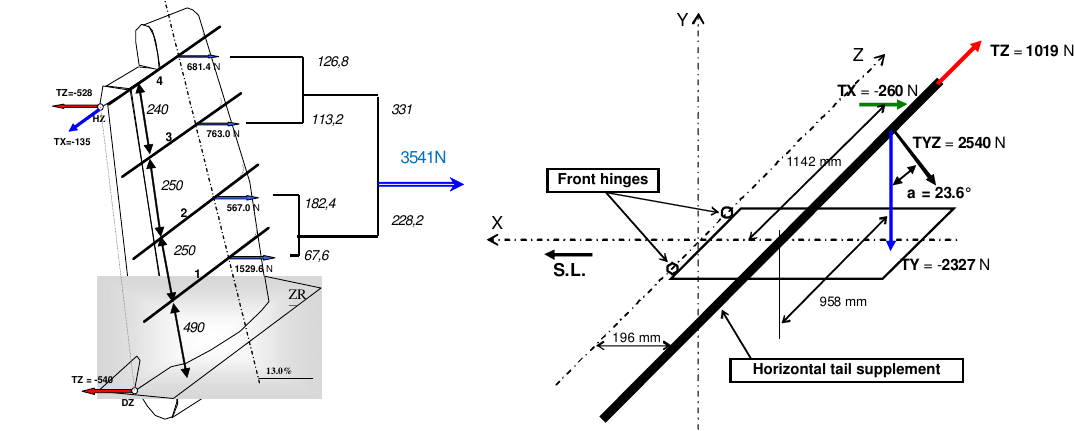
Fig 1. Forces applied at the fin and the horizontal tail